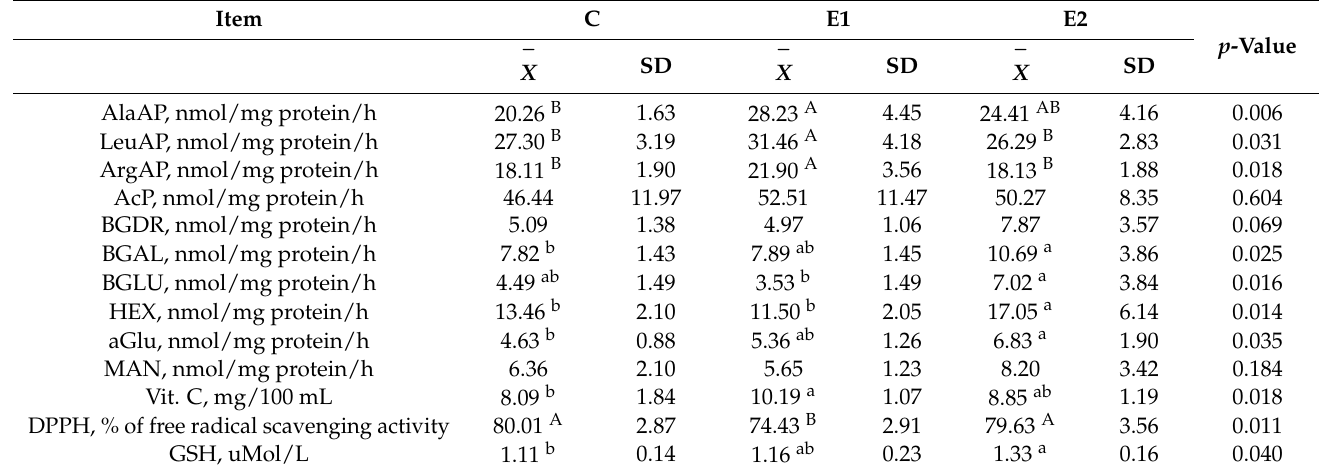
Table 6. Selected enzyme activity and antioxidant potential for chosen substances in broiler blood serum ( n =